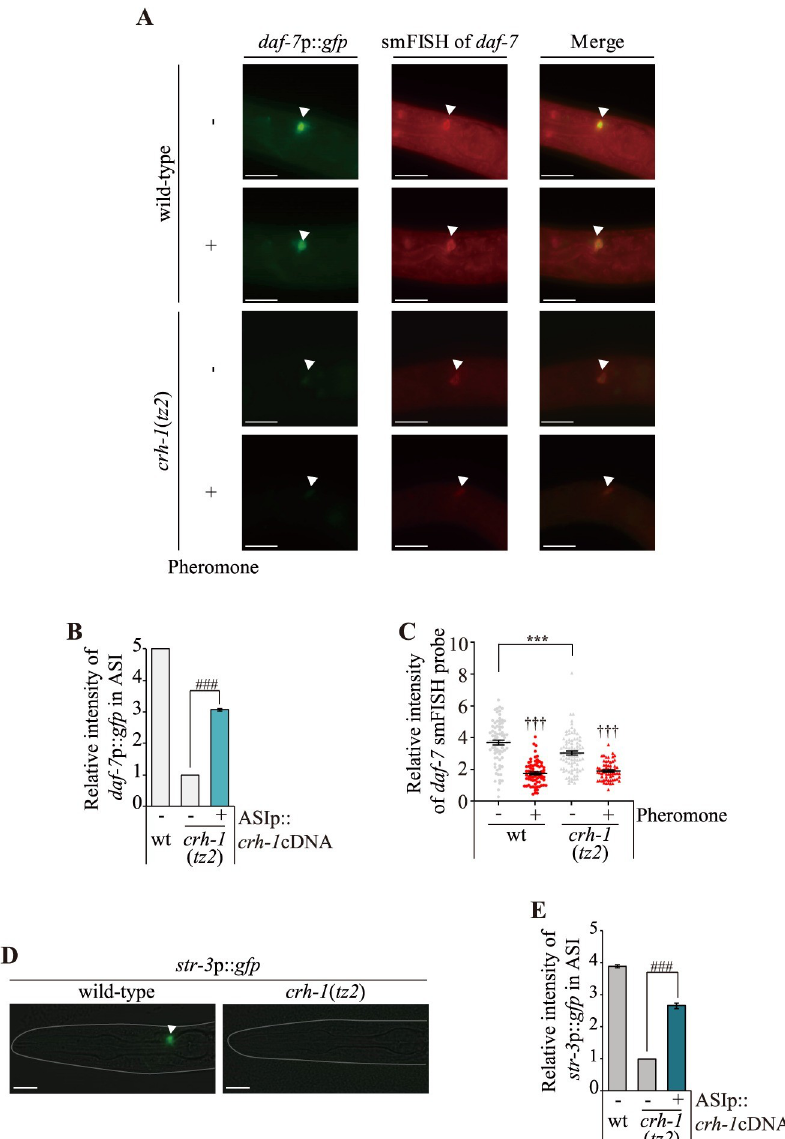
Fig 4. crh-1 mutants exhibit a decrease of daf-7 expression in the ASI neurons. (A) Representative images of L1 larval wild-type or crh-1 mutant animals expressing daf-7 p:: gfp transgene in the presence (+) or absence (-) of ascr#5. Shown is GFP expression or daf-7 smFISH signal in the ASI neurons. All images for wild-type versus crh-1 mutant animals were taken with identical camera settings, including the same exposure time. Anterior is to the left. Scale bar: 50 μ m. (B) The relative level of daf-7 p:: gfp fluorescence in the ASI neurons of L1 larval animals of the indicated genotypes in the absence (-) of ascr#5. (C) Scatter plot of fluorescence intensity of daf-7 smFISH signal in the ASI neurons of wild-type or crh-1 mutant animals in the presence (+) or absence (-) of ascr#5. The median is indicated by a horizontal line. Each dot is the fluorescence intensity of a single neuron; n � 30 neurons total each, at least two independent experiments. (D) Representative images of L1 larval wild-type or crh-1 mutant animals expressing str-3 p:: gfp in the ASI neurons. Scale bar: 10 μ m. (E) The relative level of str-3 p:: gfp fluorescence in the ASI neurons of L1 larval animals of the indicated genotypes in the absence (-) of ascr#5. n � 30 for each. Error bars indicate SEM. ��� , ††† , or ### indicates different from wild-type, absence of ascr#5, or crh-1 mutants at p < 0.001, respectively (student t-test). Arrowheads indicate the ASI neurons (A and D) .